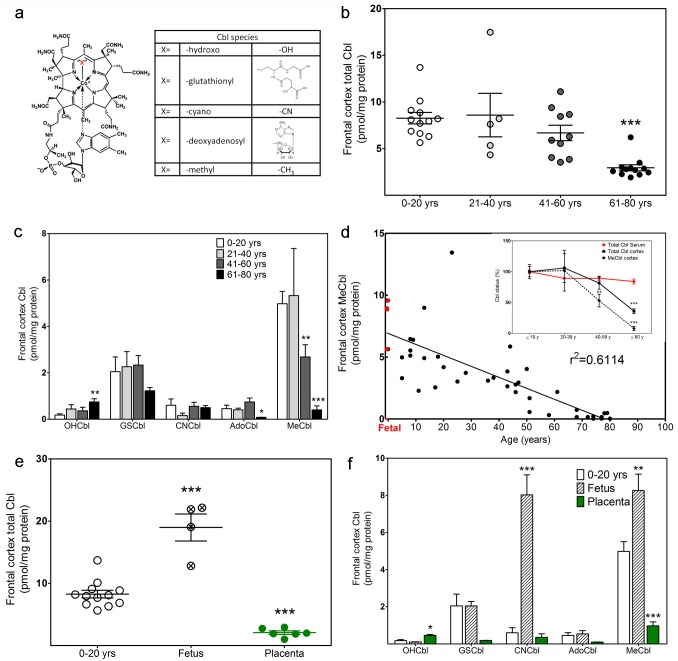
Cobalamin status in human frontal cortex.(a) The general structure of Cbl species in which “X” represents various ligands linked to the cobalt atom, giving rise to the five different Cbl species measured in postmortem frontal cortex. (b) Total Cbl levels in frontal cortex of control subjects divided into four age groups: 0–20 yrs (n = 12), 21–40 yrs (n = 5), 41–60 yrs (n = 10) and 61–80 yrs (n = 12). (c) Levels of five individual Cbl species of control subjects in four age groups. (d) Age-dependent decrease of MeCbl in human frontal cortex (n = 43). Inset: Age trends of serum Cbl, frontal cortex total Cbl and MeCbl. Serum Cbl data is from Ref. 30. (e) Total Cbl levels in placenta (n = 6), frontal cortex of fetal (n = 4) and control (0–20 yrs) subjects (n = 12). (f) Levels of five individual Cbl species in placenta (n = 6), frontal cortex of fetal (n = 4) and control (0–20 yrs) subjects (n = 12). * Indicates a significant difference from 0–20 yrs group (* p < 0.05, ** p < 0.01, *** p < 0.001).